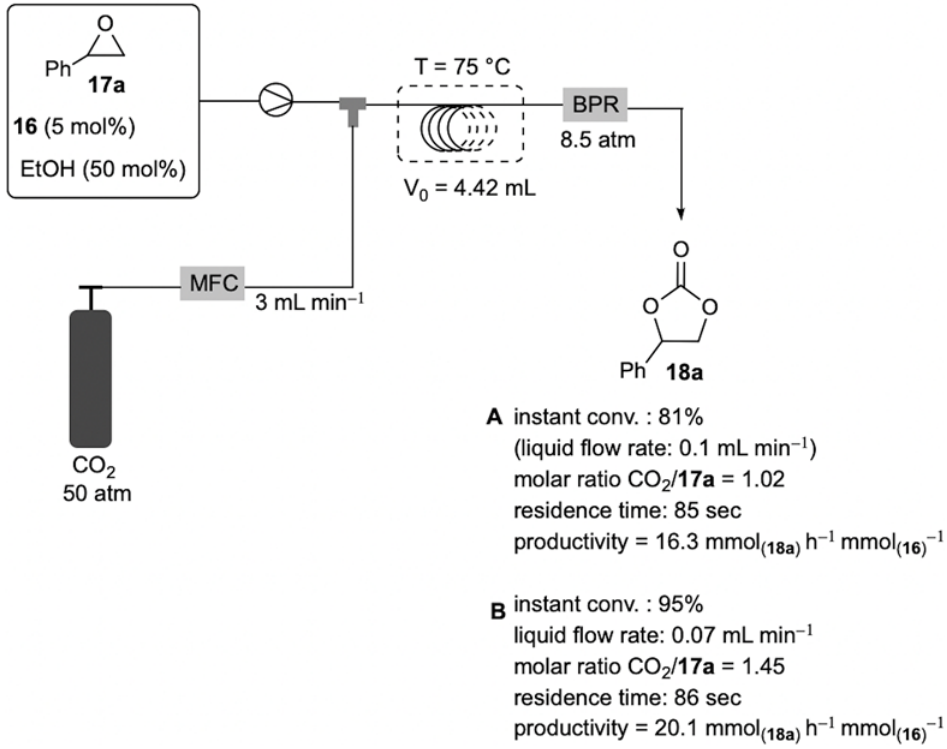
Scheme 5. Production of styrene carbonate 18a under segmented flow conditions.